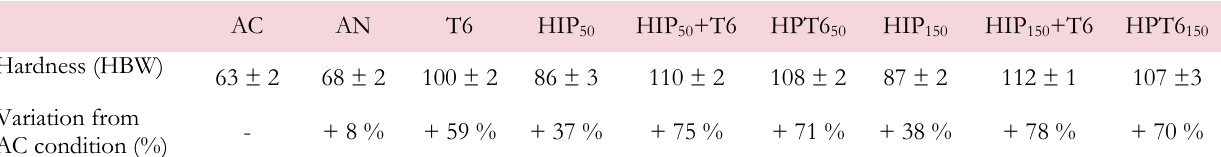
Table 2: Results of Brinell hardness tests (HBW) for the tested conditions with the percentage variation compared to the as-cast